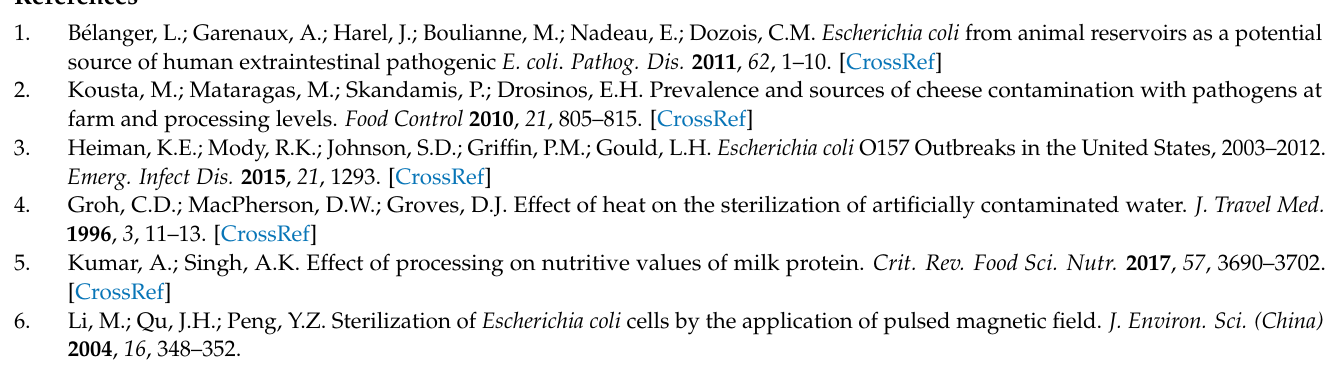
Figure S1: Confirmation of S-carboxymethyl-glutathione (CMGSH) in E. coli by a comparison with its standard, Figure S2: Scores plot with quality control (QC)